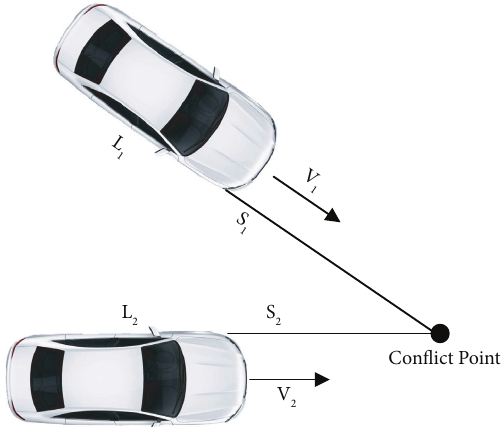
Figure 3: Lane-change conflict diagram.